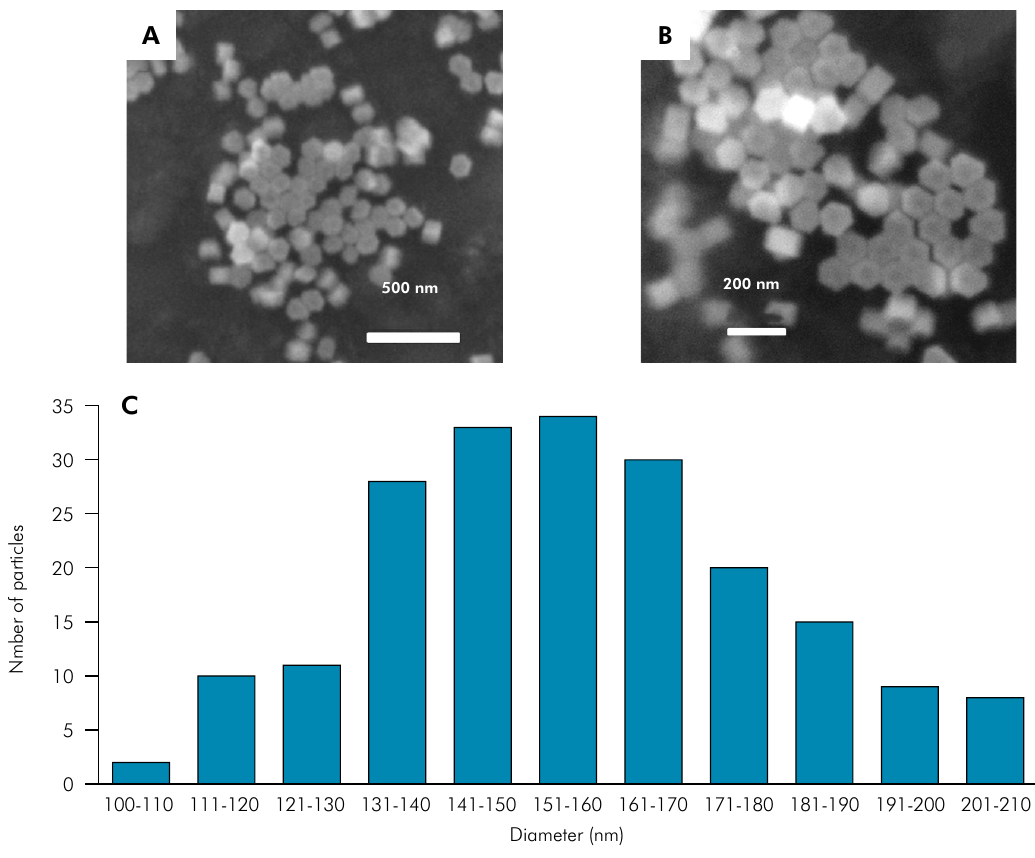
Figure 4. SEM images of b-NaYF :30%Yb/0.5%Tm synthetized NPs at (A) 100,000X and (B) 150,000X magnification. (C) Histogram 4 of the particle sizes obtained from SEM images of 200